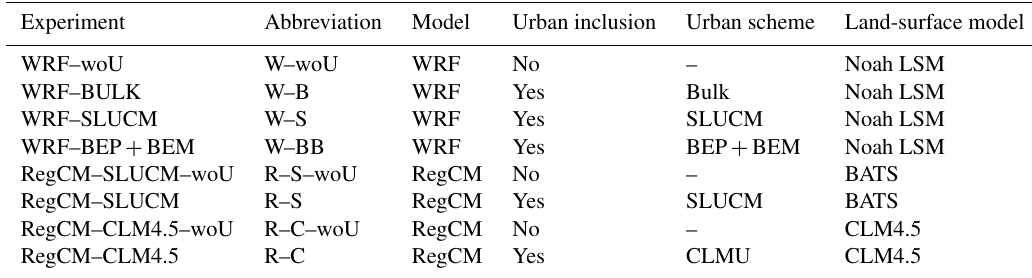
Table 2. Summary of simulation experiment